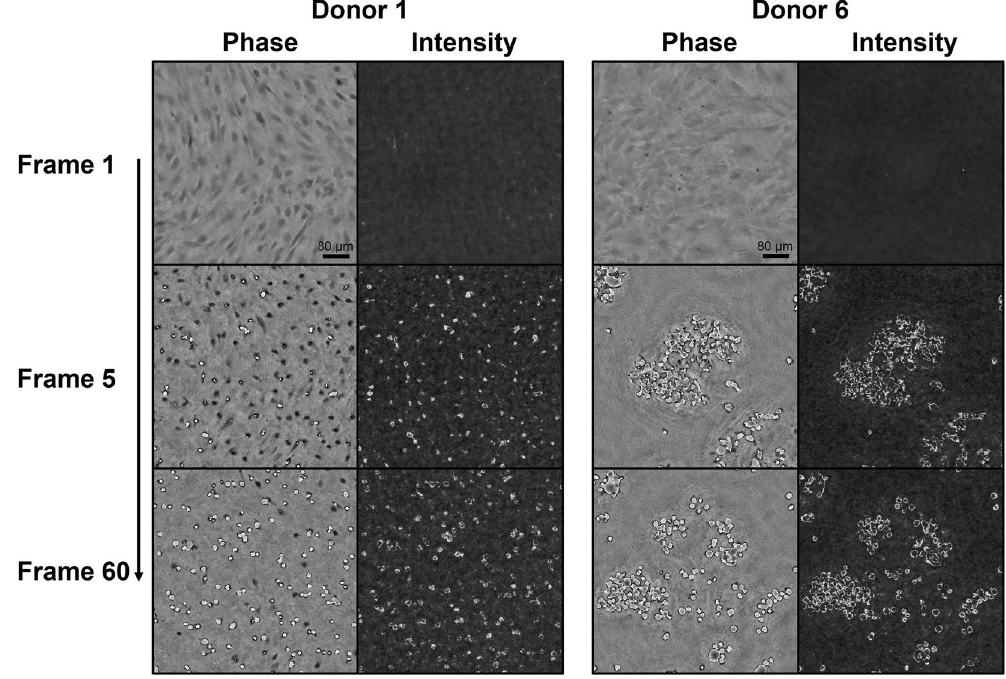
Figure 4. Visualisation of the detachment response for two different donors. The raw phase and intensity image were shown at frame 1, 5 and 60.